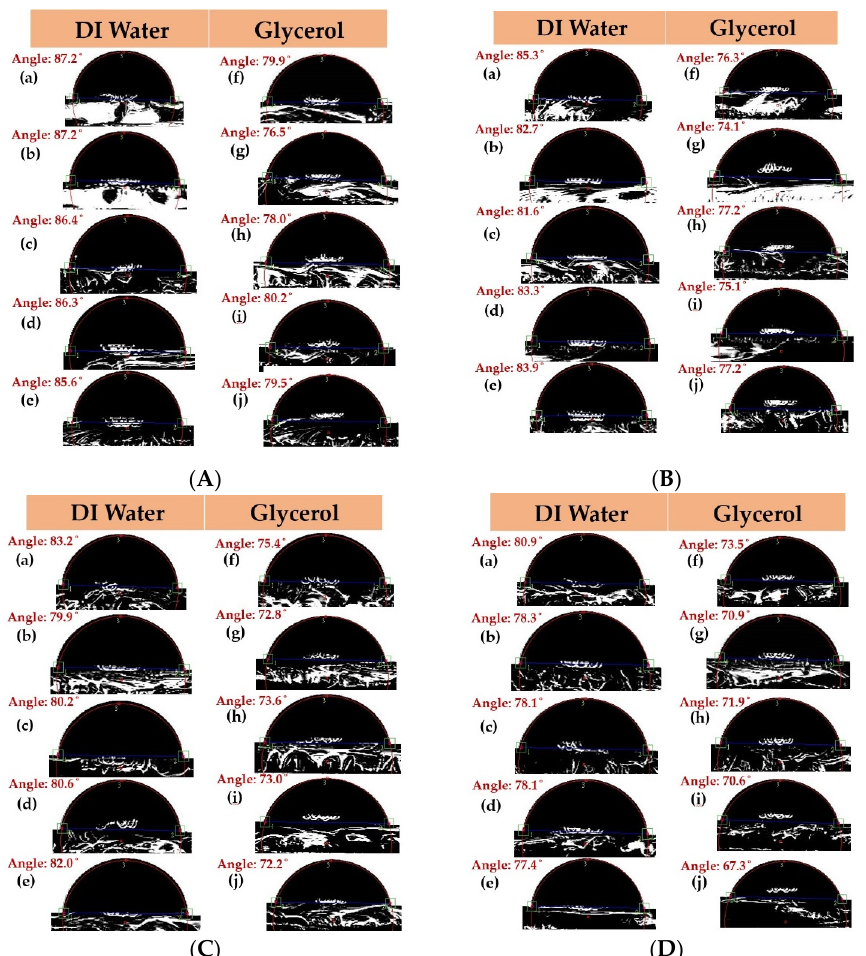
Figure 6. Contact angles of four conditions: ( A ) RT, ( B ) following annealing at 100 °C, ( C ) following annealing at 200 °C, and ( D ) following annealing at 300 °C. DI water: ( a ) 10 nm, ( b ) 20 nm, ( c ) 30 nm, ( d ) 40 nm, and ( e ) 50 nm. Glycerol: ( f ) 10 nm, ( g ) 20 nm, ( h ) 30 nm, ( i ) 40 nm, and ( j ) 50 nm.